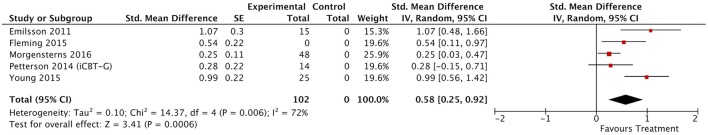
Forest plot for within-subject global functioning outcome.